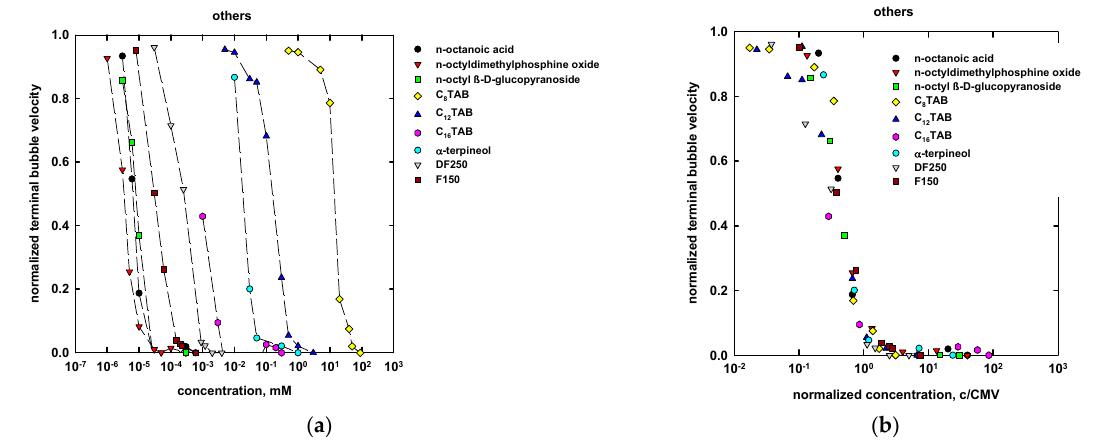
Figure 8. Influence of poly(ethylene glycol) and poly(propylene glycol) alkyl ethers concentration expressed in mM ( a ) and normalized surfactant concentration ( c /CMV) ( b ) on the normalized terminal bubble velocity.